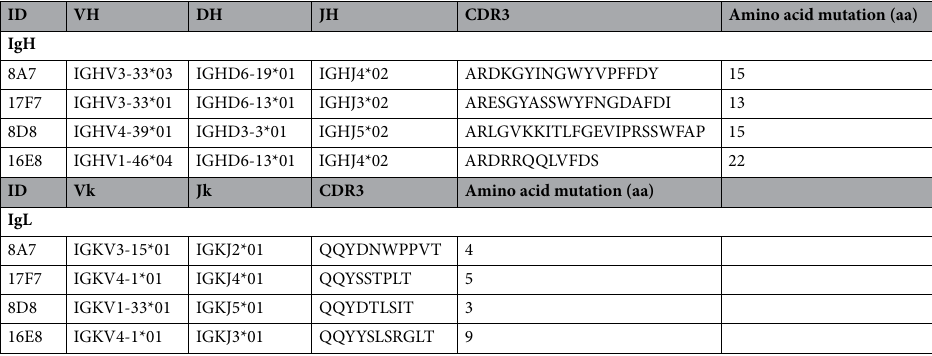
Table 2. Gene usage and CDR3 sequence of cloned immunoglobulins. CDR complementarity determining region, aa amino